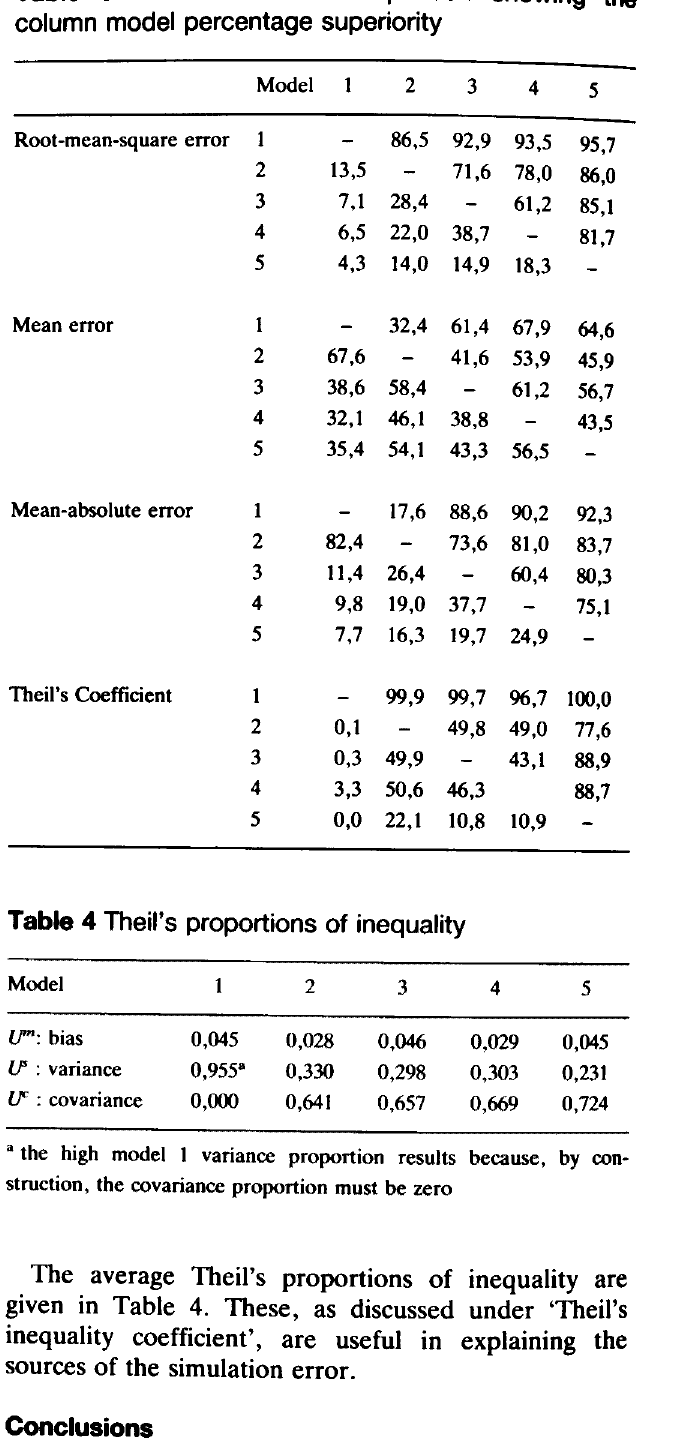
Table 1 Expected returns models